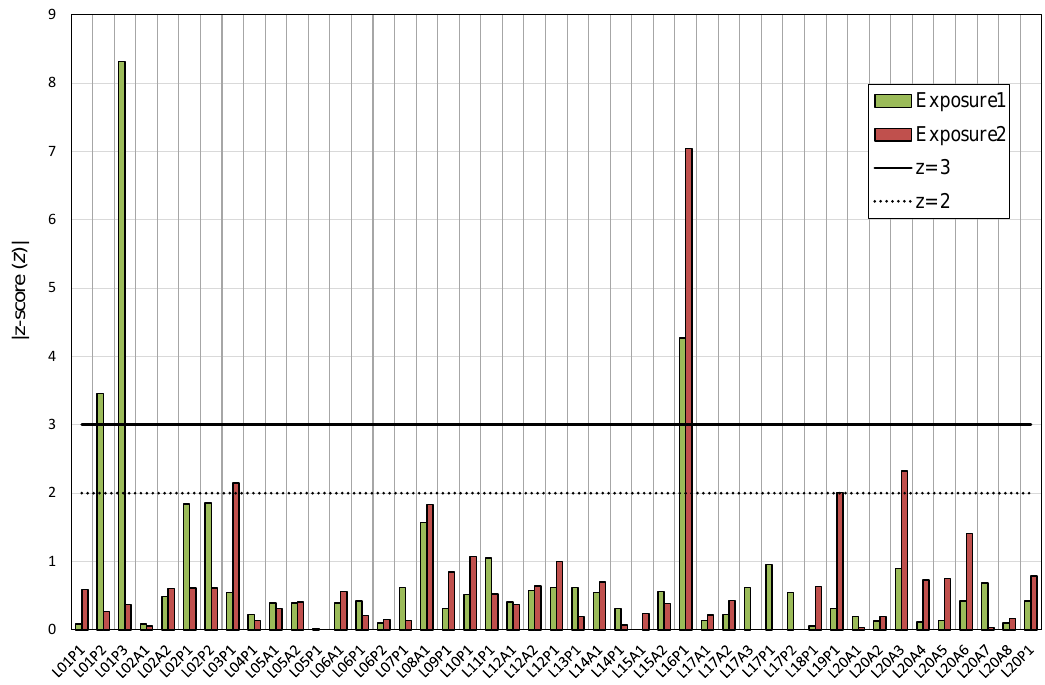
Figure 9. Absolute values of z-score for the first and second exposure. Table 7. Percentage of results that are within the limits for relative difference D (%), Zeta score ( 𝜁 ), and z-score ( 𝑧 ) for each exposure period classified by passive detectors and active monitors.